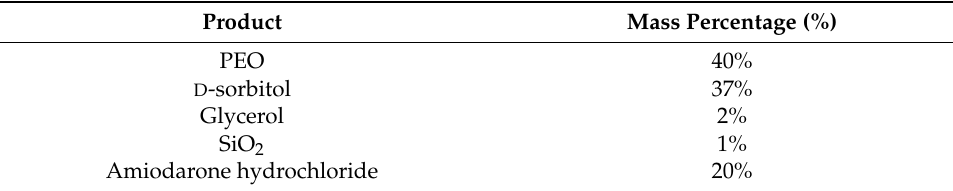
Table 1. Summary of the mass percentage of each product for all